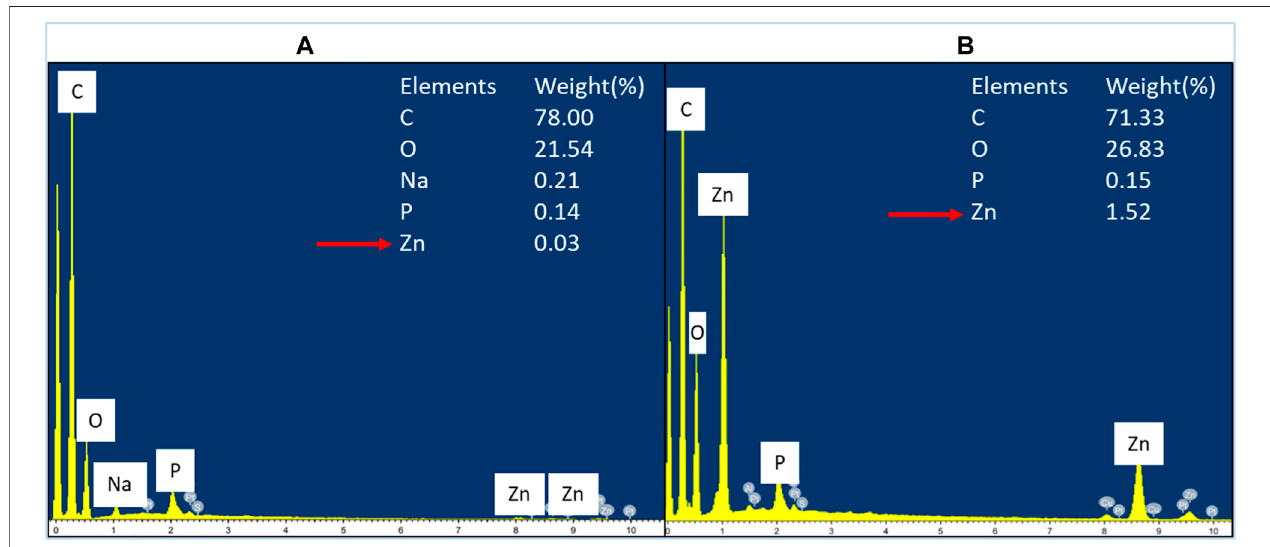
FIGURE 8 | EDX spectrum of negative control of E. faecalis (A) and E. faecalis treated with 160 μ g/ml of ZnO NPs for 24 h (B) .